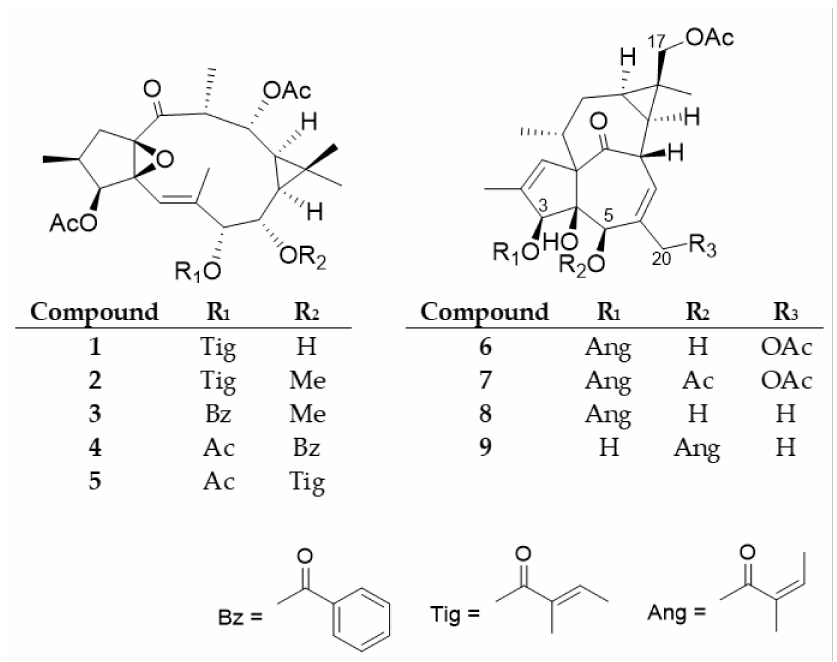
Figure 2. Structures of the isolated diterpenoids ( 1 – 9